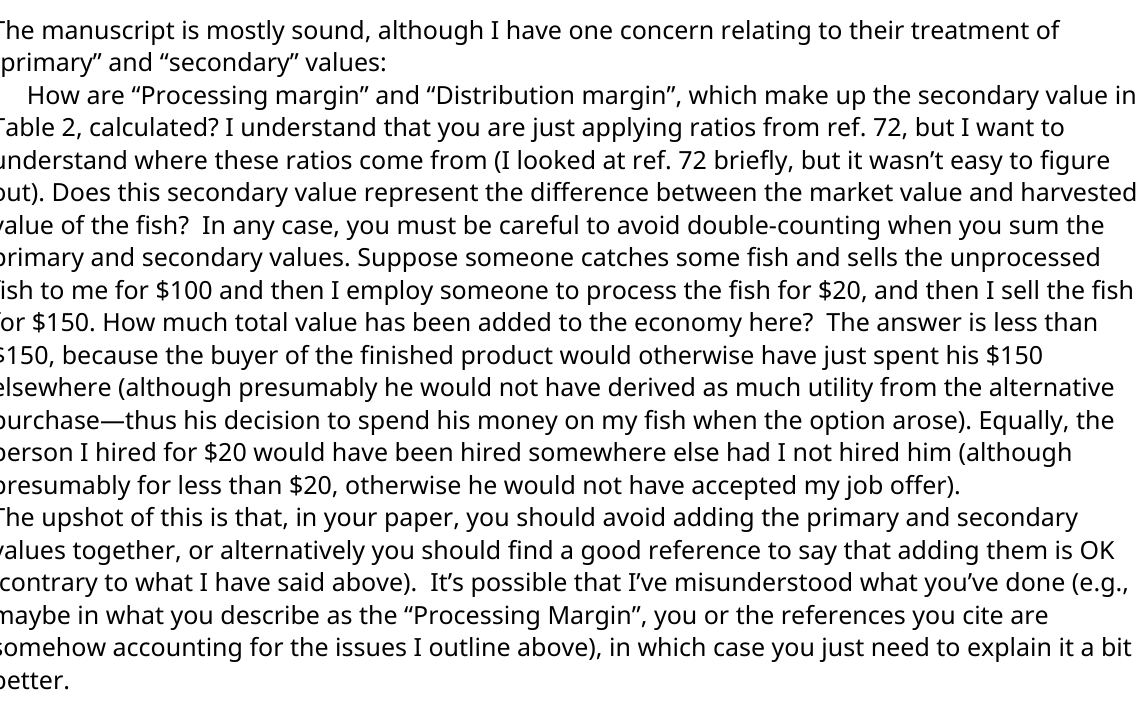
Figure 1 legend: “Figure and Maxtent potential distribution model”. Do you mean